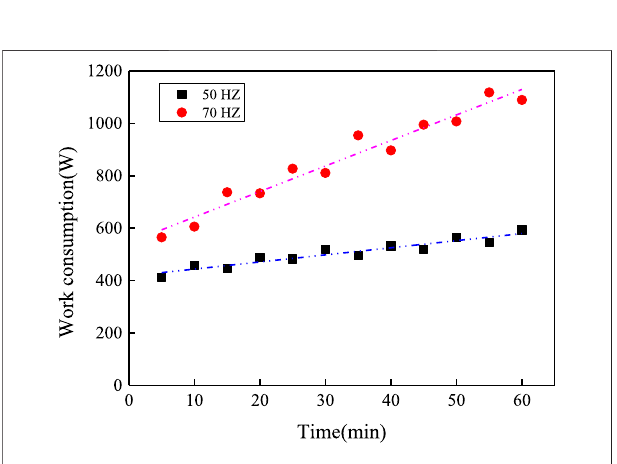
FIGURE 2 | Comparison of experimental and theoretical calculation of instantaneous values.